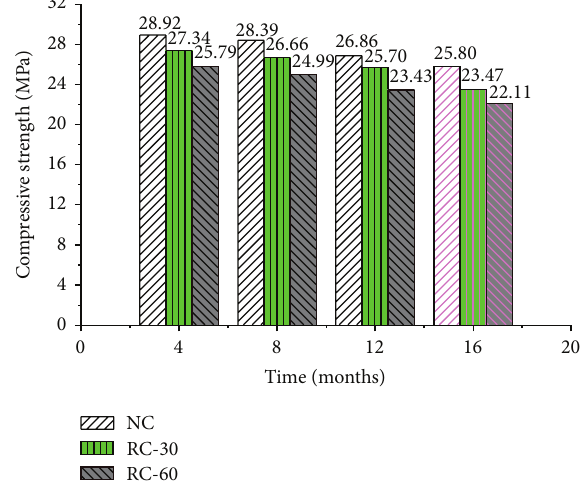
Figure 2: Compressive strengths of RAC with seawater corrosion.